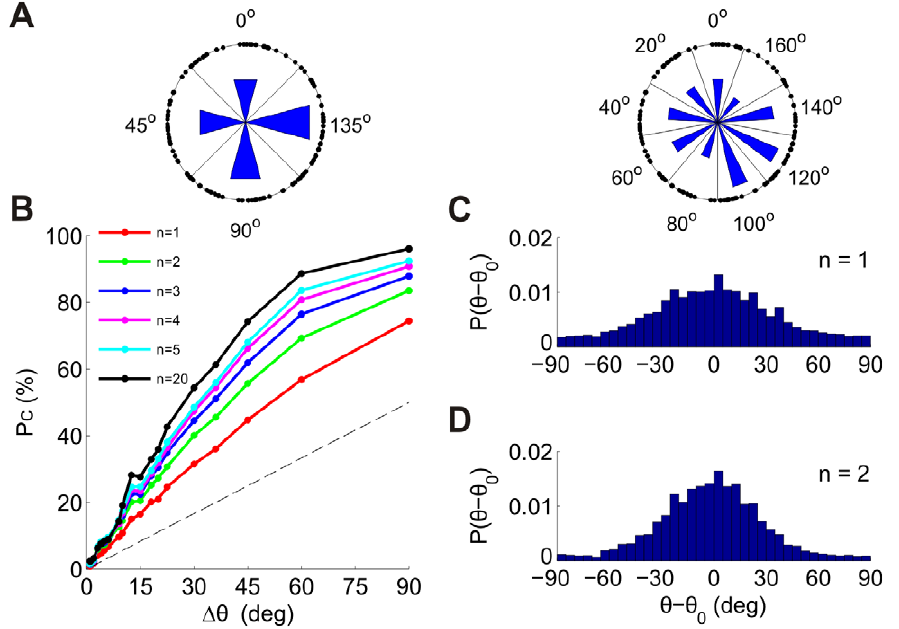
Figure 9. Discrimination among multiple alternatives using the n -tWTA in populations of neurons. (A) The tuned neurons in one of the datasets (dataset 3 in Table 1) were divided according to their preferred orientations into M groups of equal orientation width, Dh =180 u / M . To illustrate this division, each point on the circle represents a neuron (the angle is twice the preferred orientation). The left plot illustrates division into M =4 groups of width Dh =45 u and the right plot illustrates division into M =9 groups of width Dh =20 u . Each group is labeled by the orientation of its center. The lengths of the blue bars are proportional to the number of neurons in each group. (B) Probability of correct discrimination of the n - tWTA as a function of group width. The different curves correspond to n =1,2,3,4,5 and 20. (C–D) Distribution of errors for group width of Dh =1 u for n =1 (C) and n =2 (D).